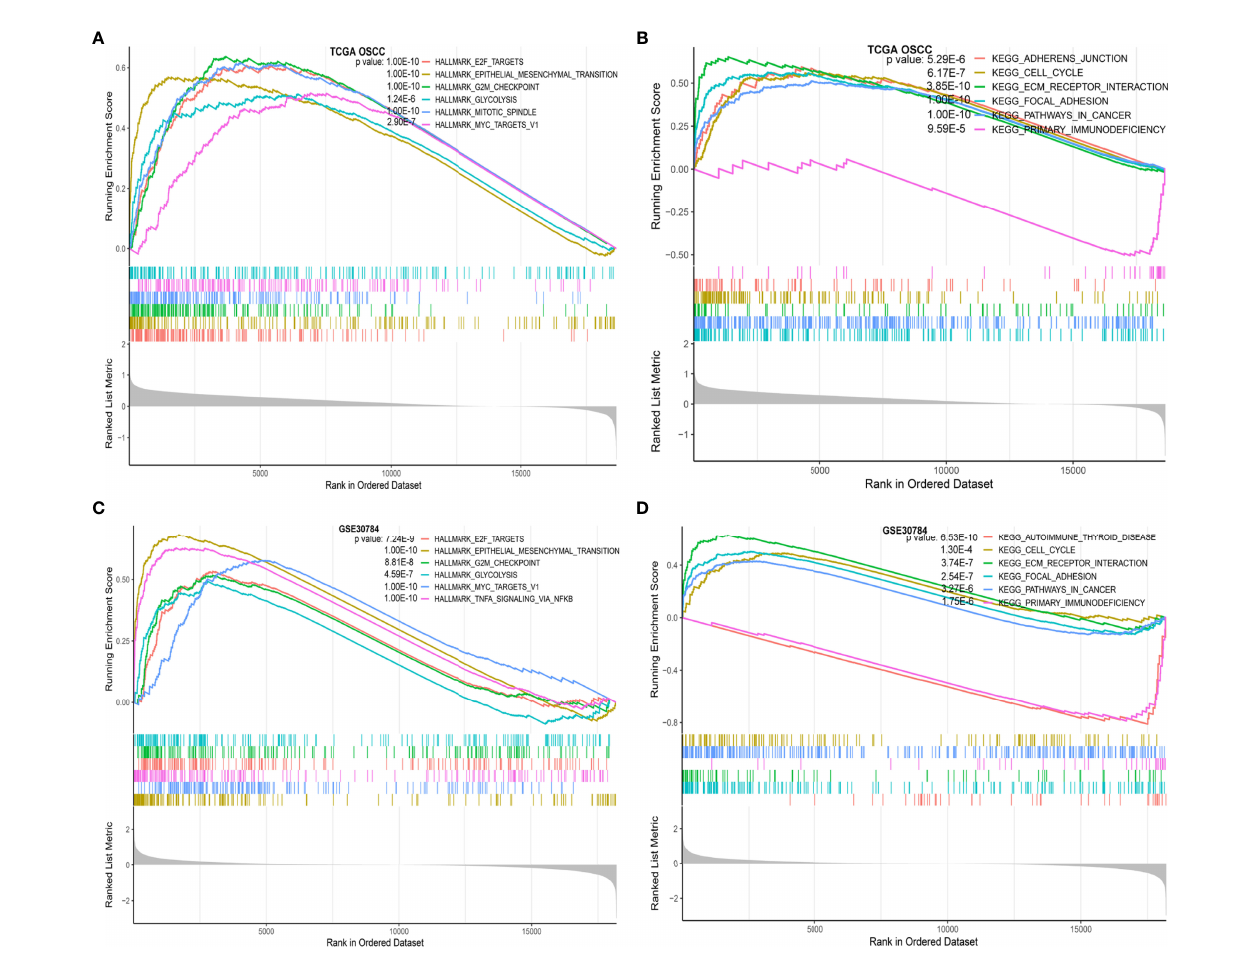
FIGURE 4 | Functional annotation of IGF2BP2 in OSCC. (A) The GSEA results show the functional enrichment of hallmark gene sets based on IGF2BP2 expression in TCGA-OSCC dataset; (B) GSEA results show the functional enrichment of KEGG gene sets based on IGF2BP2 expression in TCGA-OSCC dataset; (C) GSEA results show the functional enrichment of hallmark gene sets based on IGF2BP2 expression in the GSE30784 dataset; (D) GSEA results show the functional enrichment of KEGG gene sets based on IGF2BP2 expression in the GSE30784